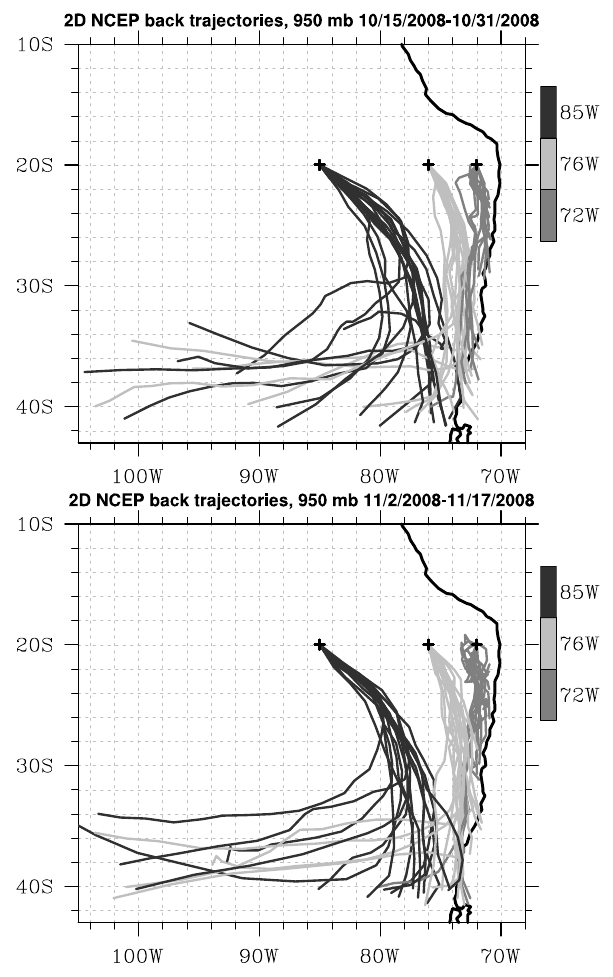
Fig. 4. Five-day isobaric (950hPa) boundary layer airmass back- ward trajectories initiated at 72 ◦ W, 76 ◦ W and 85 ◦ W as grey- scaled, initiated daily at 00:00UTC throughout 15–31 October and 1–15 November, respectively. Trajectories terminate on surface